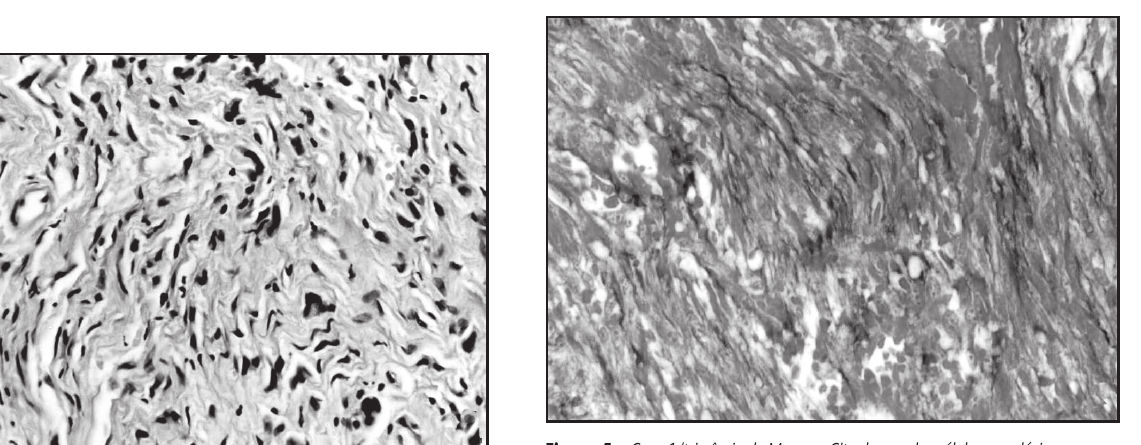
Figura 5 – Caso 1/tricrômio de Masson. Citoplasma das células neoplásicas corando-se em vermelho (200x)